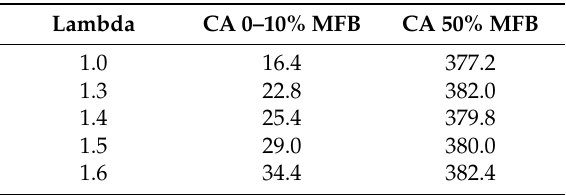
Table 3. Burn duration.